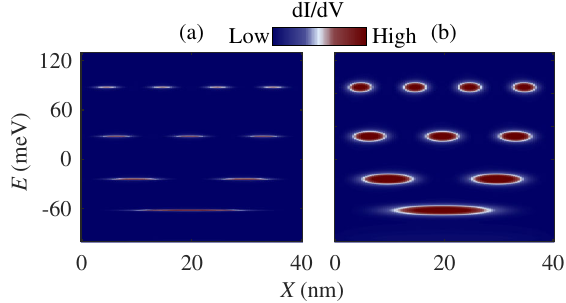
FIG. 16. Quantized resonances in the calculated LDOS of a quantum box with j R j 2 ¼ 0 . 9 . (a) Resonances of the lowest energy band, calculated from the experimentally inferred dispersion. (b) Same resonances after instrumental broadening due to temperature (about 1 meV) and finite probing amplitude (3